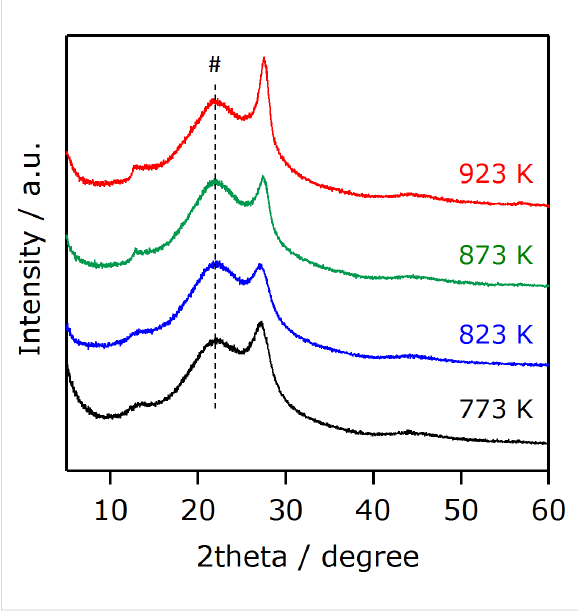
Figure 1: XRD patterns of g-C 3 N 4 synthesized at different temperatures. A broad peak at around 22 degree, indicated by #, in XRD patterns originated from a glass folder for the measurement.